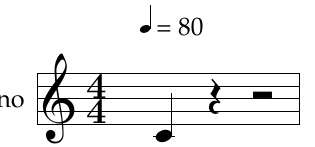
Figure 1. Resulting score from Iteration 0 (Audio S1).